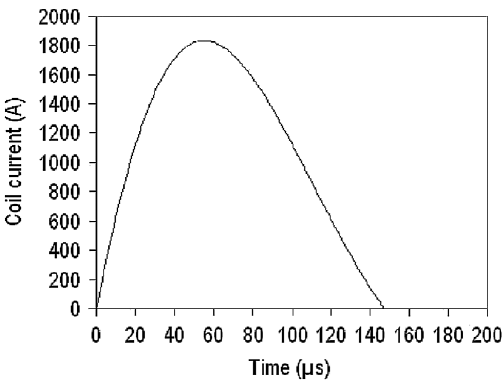
FIG. 1. Cross-section view of Alameda Applied Sciences Corporation’s ultrafast gas valve.